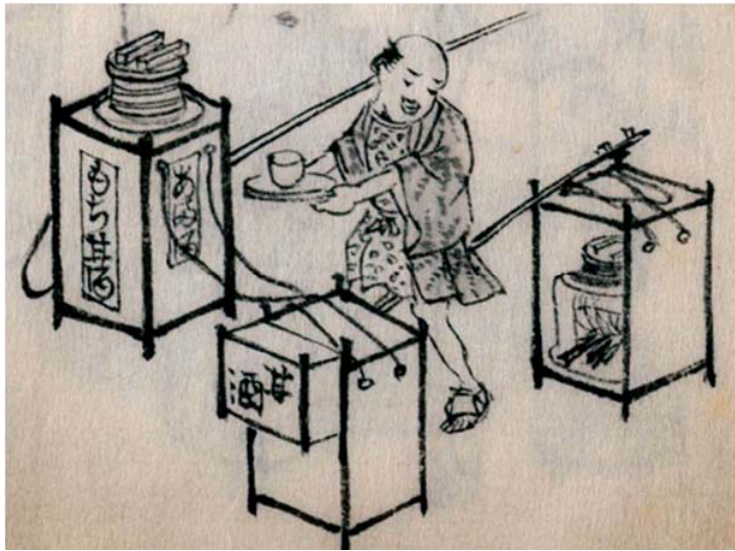
Figure 3. Koji amazake peddler in the Edo period [3].